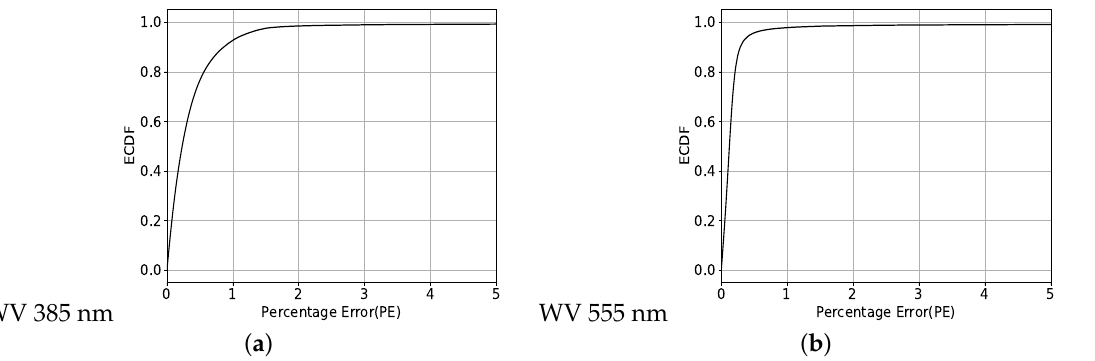
Figure 9. ECDF vs PE for M 11 at wavelengths ( a ) 385 and ( b ) 555